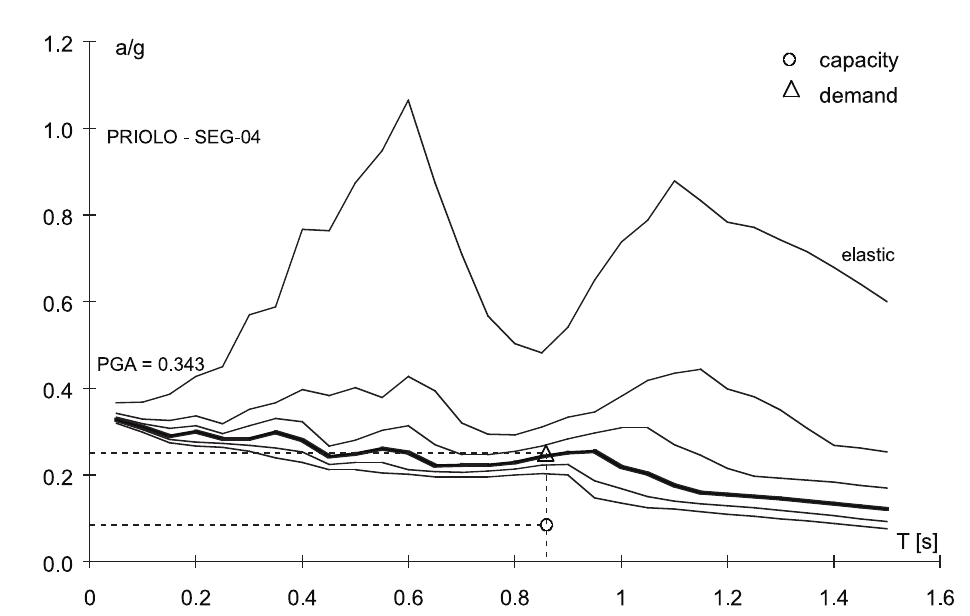
Fig. 12. Spectral analysis of the Catania building. Elastic spectra and inelastic strenght spectra for fixed ductilities; thick line corresponds to µ =